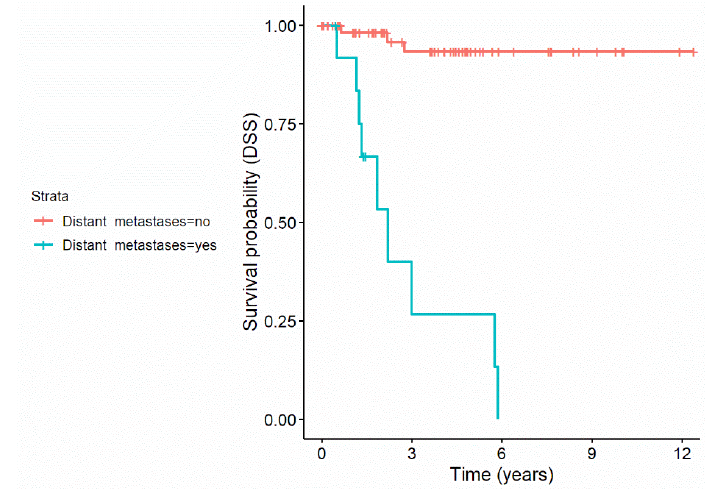
Figure 2. Disease specific survival curves of patients with and without distant metastases. Table 5. Univariate and multiple Cox regression for DSS.